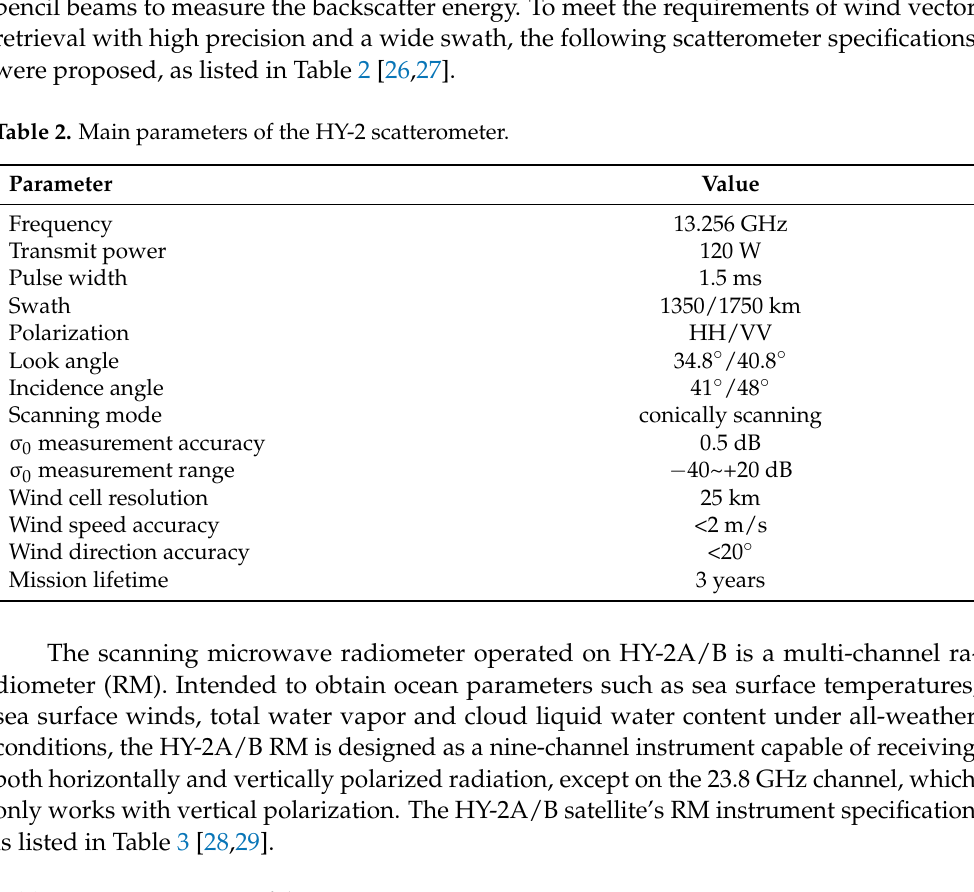
Table 3. Main parameters of the HY-2